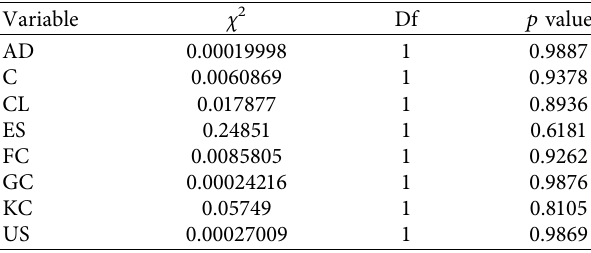
Table 5: Results of the Box–Pierce and Ljung–Box